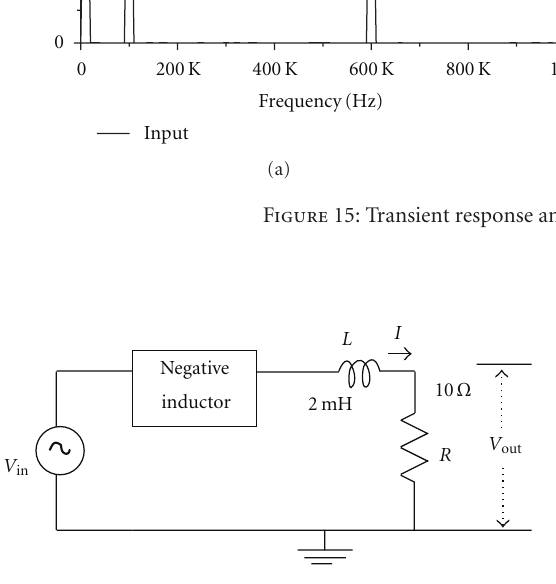
Figure 16: Inductance-nullifying circuit.